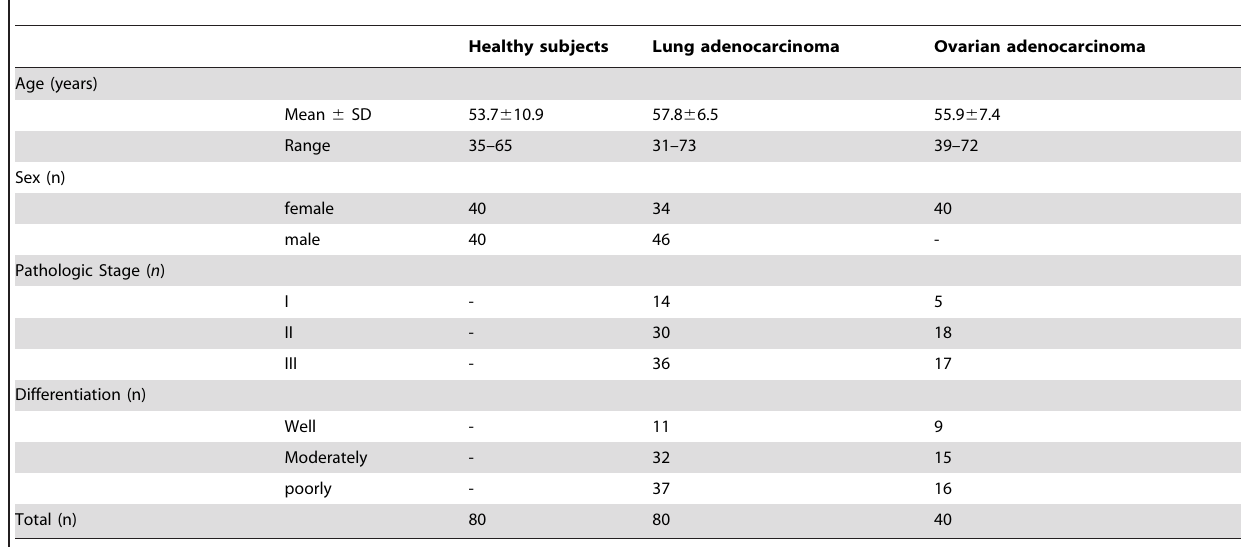
Table 1. Demographic characteristics and clinical data for healthy subjects, patients with lung and ovarian mucinous